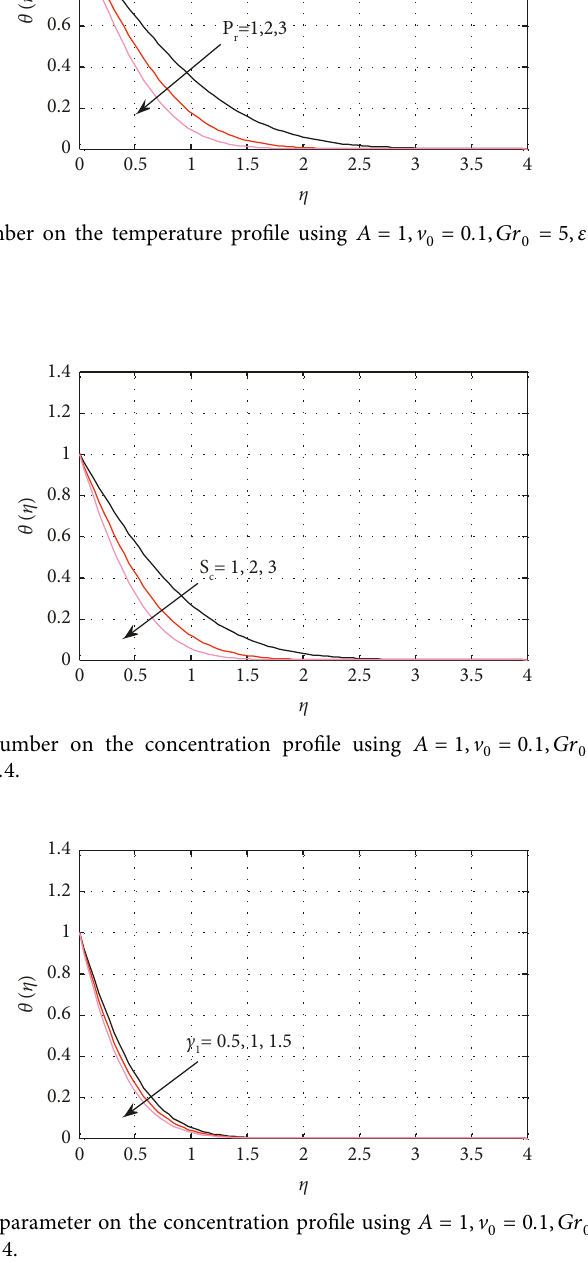
� 5 , R � 0 . 1 , S � 1 . 5 ,P � 4. m d c r